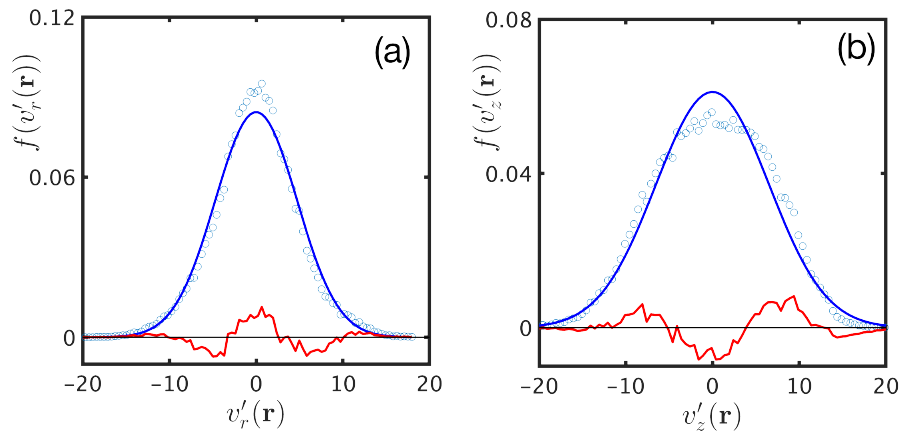
Figure 12. Distributions of ( a ) radial, and ( b ) axial velocity fluctuations at a fixed location. The blue lines are the best Gaussian fit to the data and red lines are deviations from the